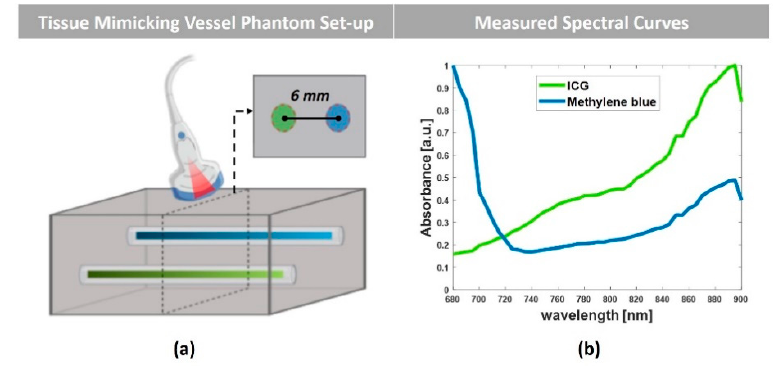
Figure 2. ( a ) Schematic of the tissue-mimicking vessel phantom. ( b ) The PA absorbance spectral graph of the agents measured by using VevoLab.